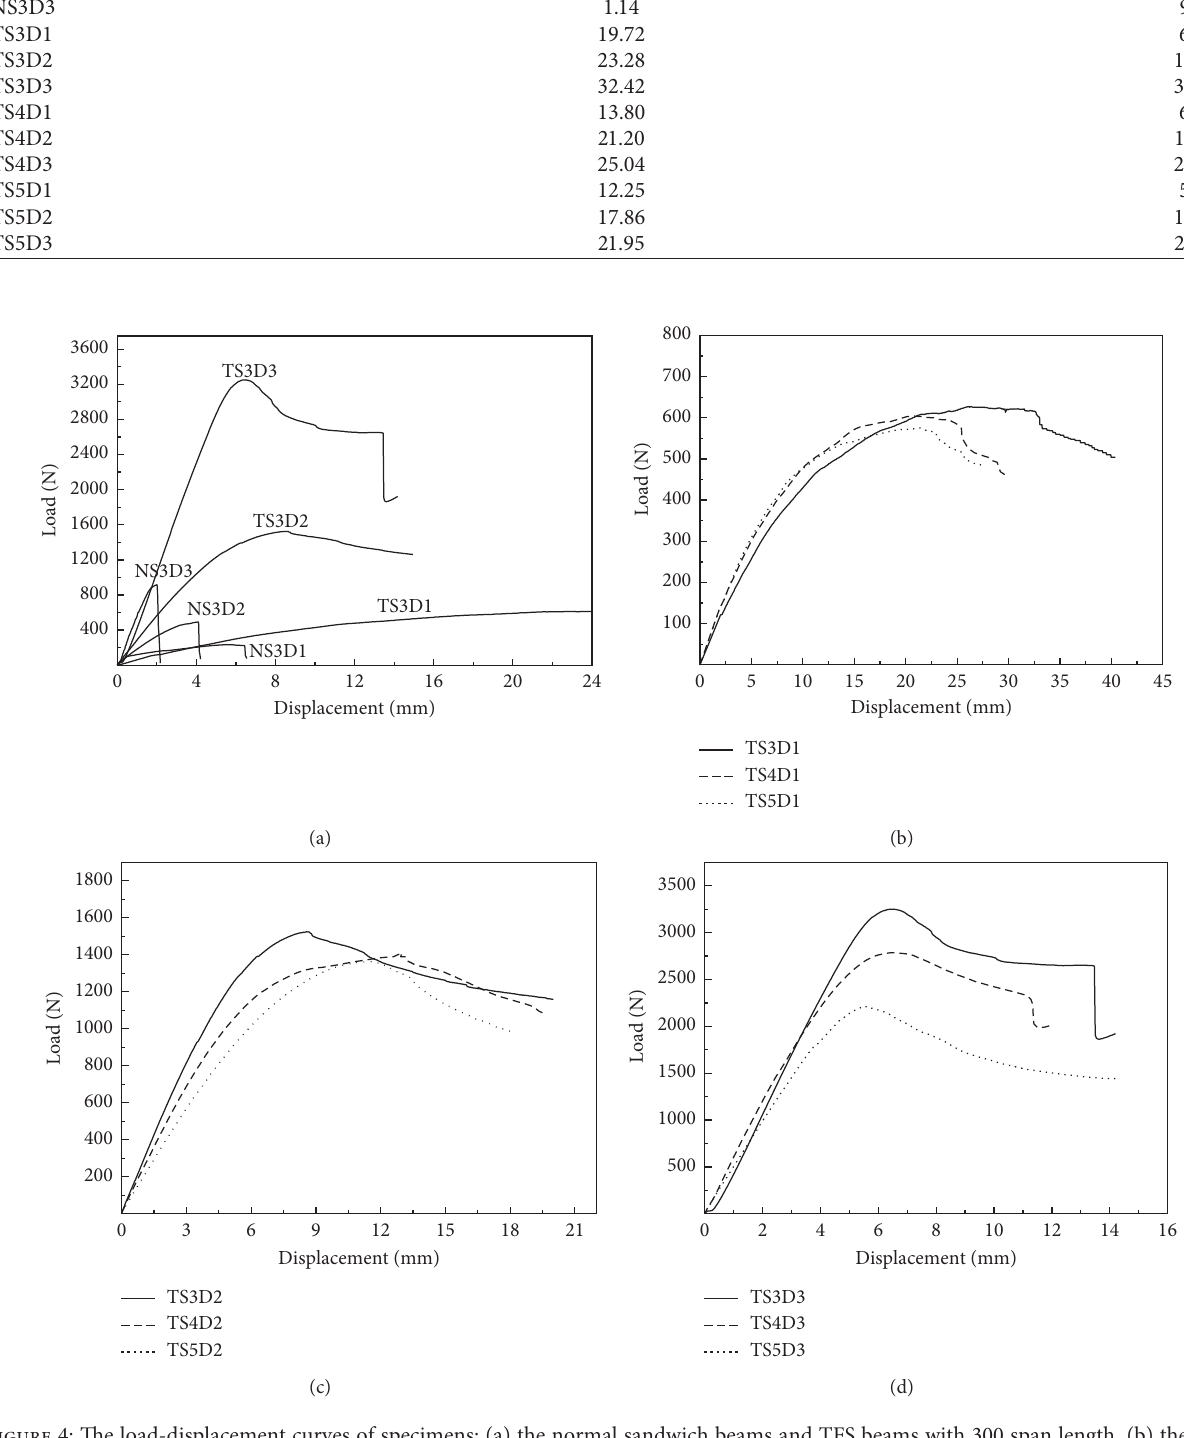
Figure 4: The load-displacement curves of specimens: (a) the normal sandwich beams and TFS beams with 300 span length, (b) the TFS beams with different span length and 35kg/m 3 foam core, (c) the TFS beams with different span length and 80kg/m 3 foam core, and (d) the TFS beams with different span length and 150kg/m 3 foam core.